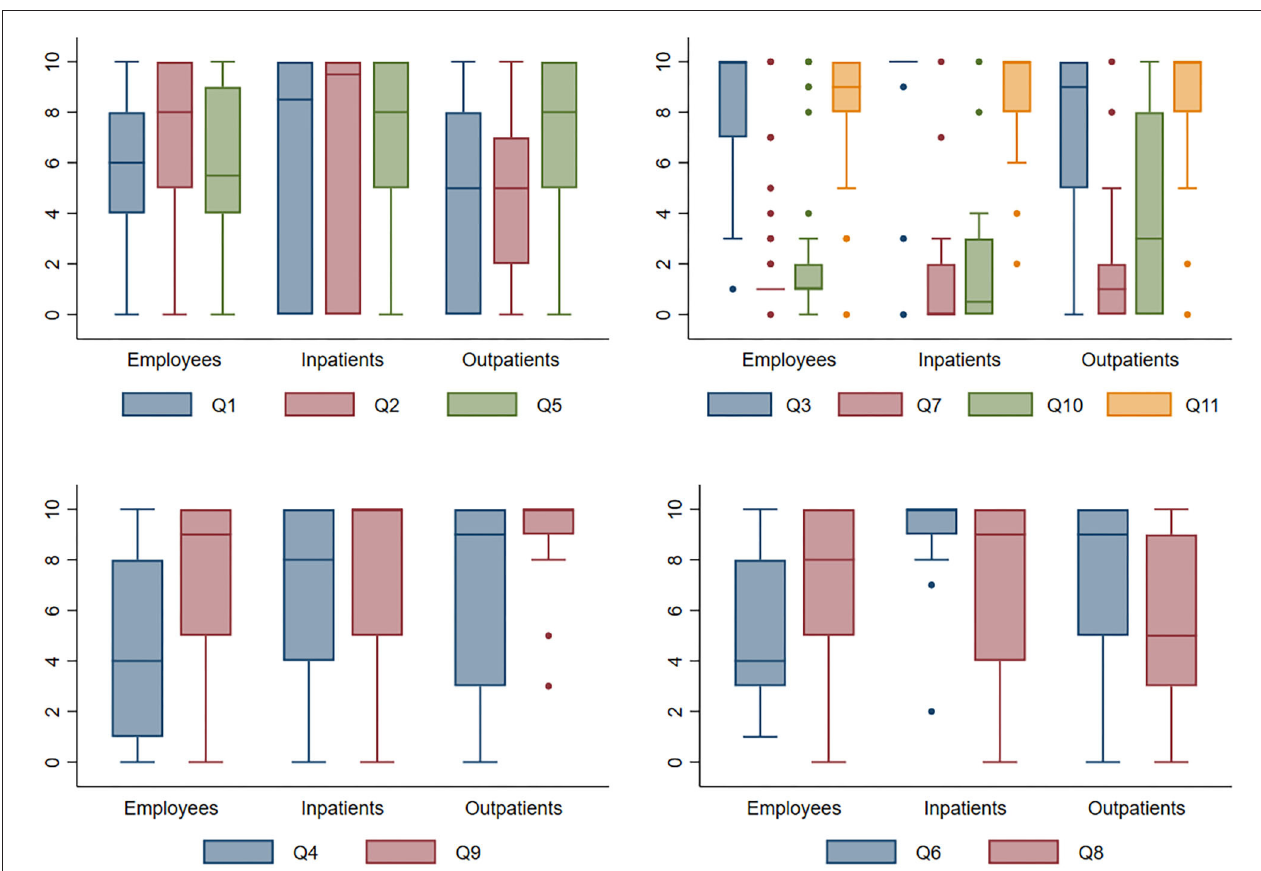
FIGURE 1 | The boxes present median and first and third quartiles. The lines at the bottom/top vertical bars present adjacent values defined as the most extreme values within 1.5 × IQR, where IQR is interquartile range, of the nearer quartile. The dots present outliers. Q1–Q11 corresponds to the statements in the